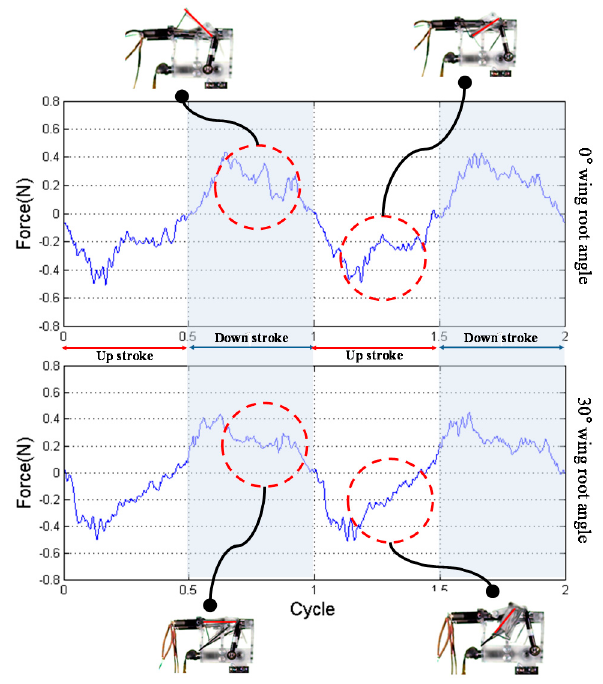
Figure 20. Drag force comparison between 0° and 30° wing root angle at 15 Hz flapping frequency.